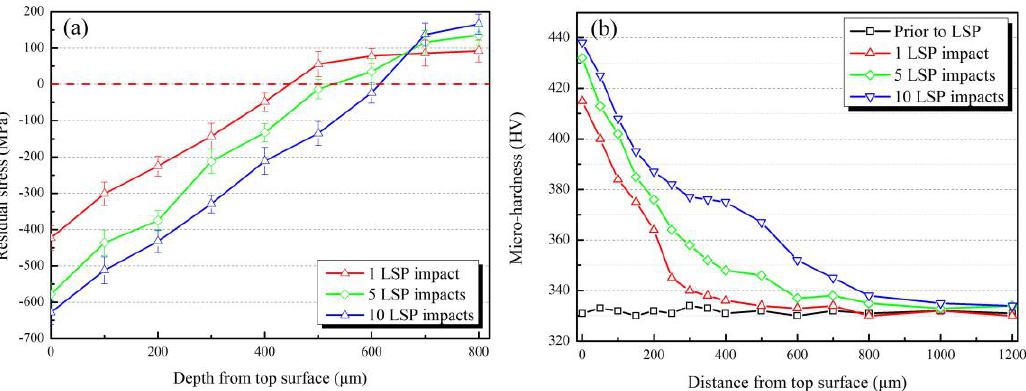
Figure 6. ( a ) Residual stress and ( b ) micro-hardness distribution on cross section with different LSP impacts.